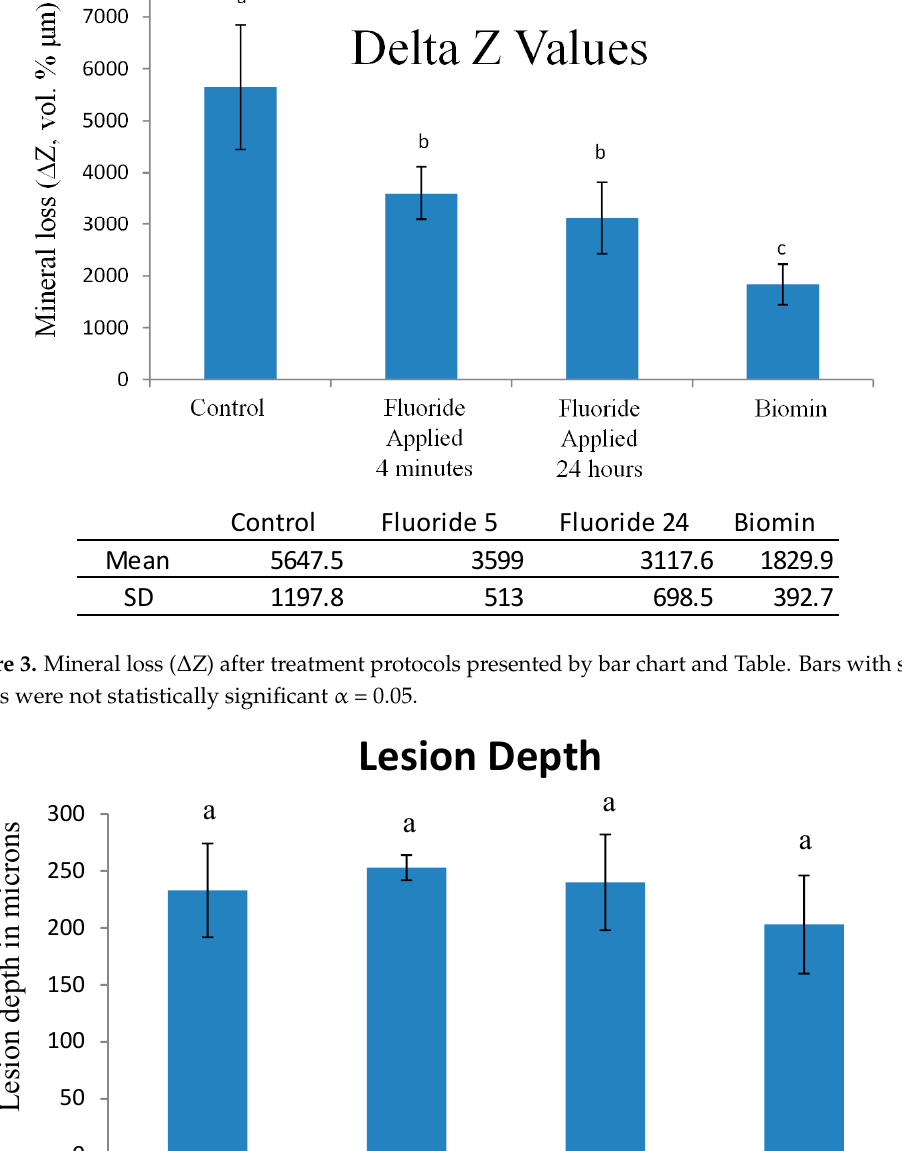
Figure 2. Transverse Micro Radiography (TMR) images for the four groups.